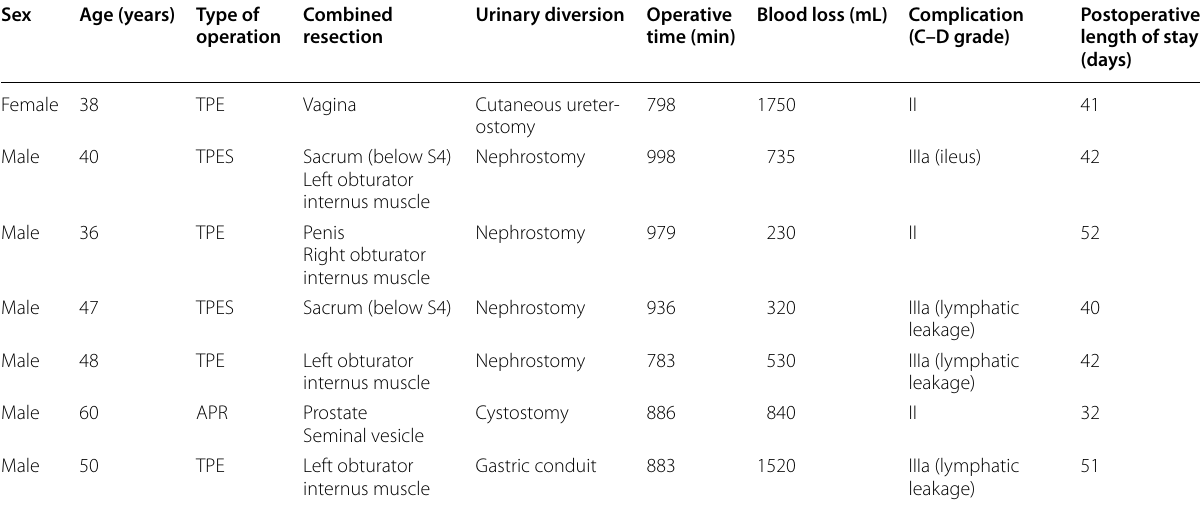
C–D Clavien–Dindo, TPE total pelvic exenteration, TPES total pelvic exenteration with sacrectomy, APR abdominal perineal resection